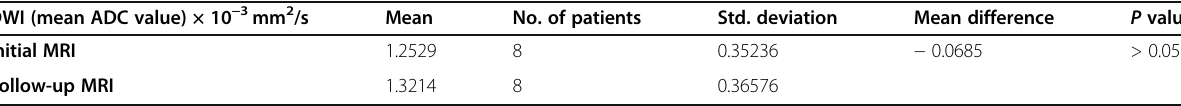
Table 3 Analysis of mean ADC values in poor response